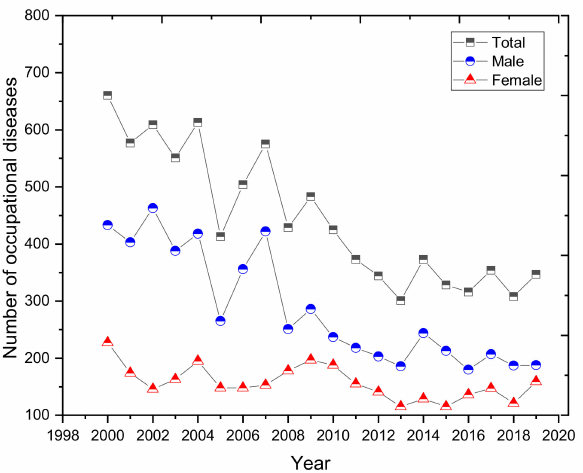
Figure 8. Development of the number of diseases in terms of the gender of workers (2000–2019).